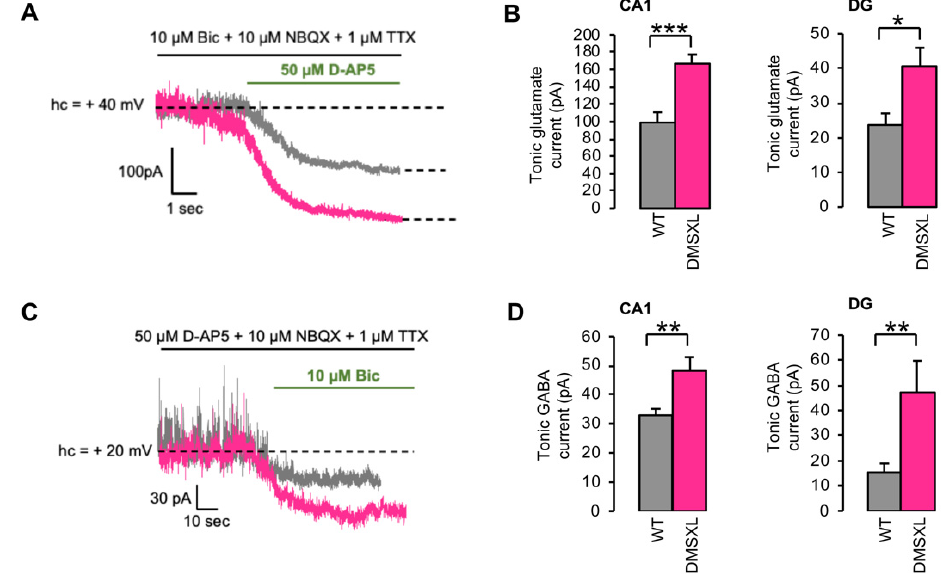
Figure 3. Glutamate and GABA tonic currents in CA1 and DG. ( A ) Representative example of a glutamate NMDA-dependent tonic current, recorded at +40 mV holding potential in CA1, in WT (grey) and DMSXL (magenta) mice at 1–2 months of age. ( B ) The mean amplitude of tonic glutamate currents was evaluated after the action of the NMDAR antagonist D-AP5 and was statistically higher in the CA1 and DG of DMSXL mice ( n = 8 mice, n = 14 neurons), compared with WT controls ( n = 6 mice, n = 13 neurons). CA1, *** p = 0.0002; DG, * p = 0.012. ( C ) Representative example of a GABA-dependent tonic current, recorded at +20 mV holding potential in DG, in WT (grey) and DMSXL (magenta) mice at 1–2 months of age. ( D ) The mean amplitude of tonic GABAergic currents was evaluated after the action of the GABAA antagonist bicuculline and was significantly higher in both hippocampal areas of DMSXL mice (CA1, n = 11 mice, n = 17 neurons; DG, n = 3 mice, n = 7 neurons), relative to WT controls (CA1, n = 8 mice, n = 17 neurons; DG, n = 5 mice, n = 13 neurons). CA1, ** p = 0.0056; DG, ** p = 0.0064.